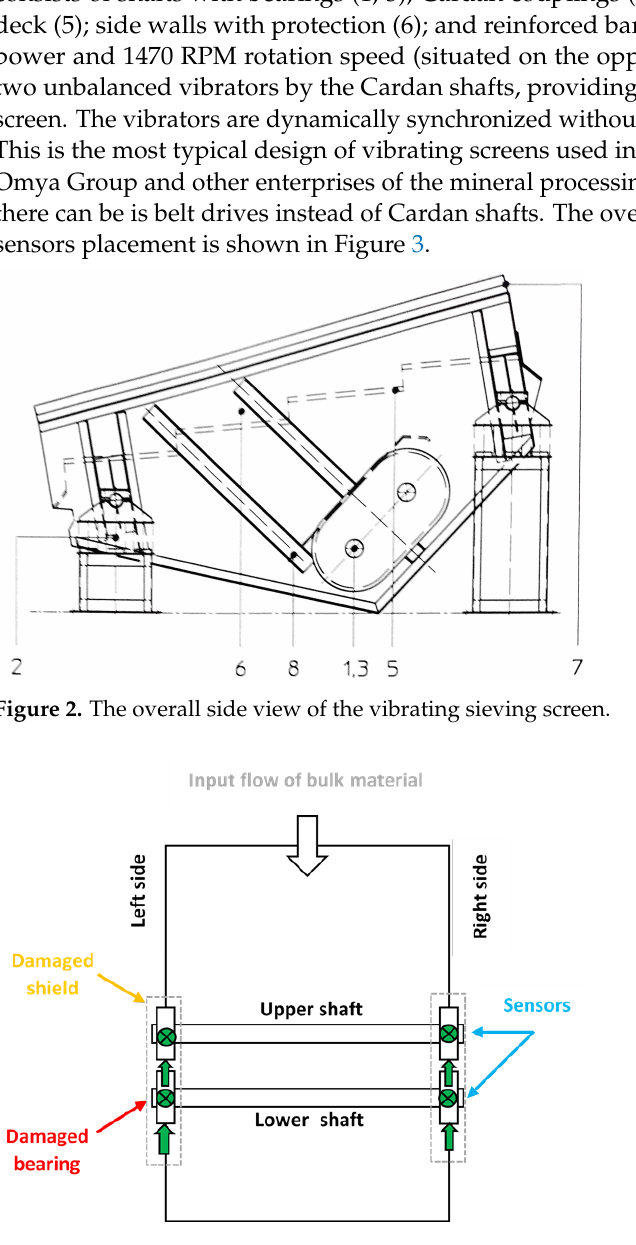
Figure 3. The overall top view with sensors placement and position of damaged bearing and vibrator